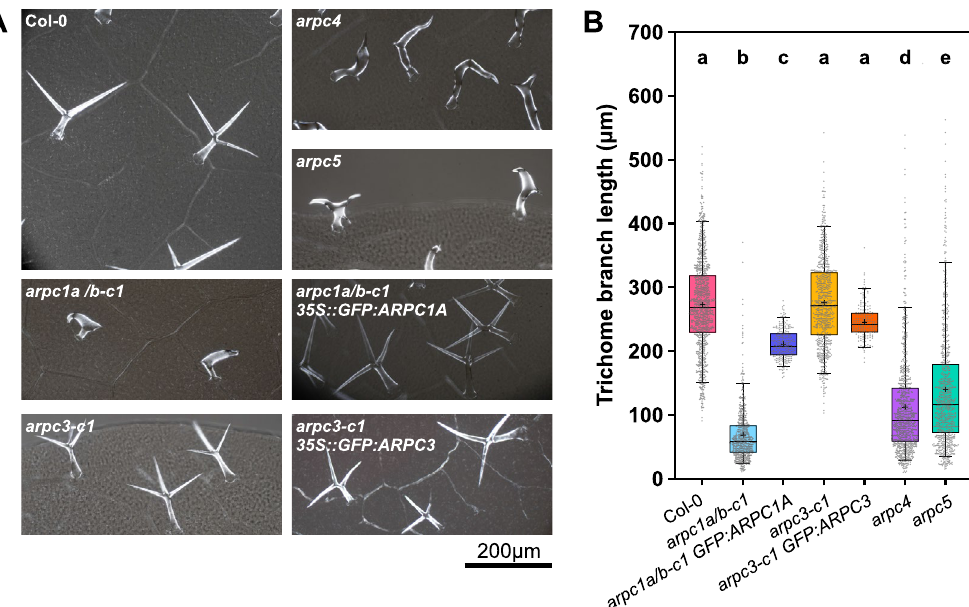
Figure 2. arpc1a/b-c1 but not arpc3-c1 show a distorted phenotype. Trichome evaluation of first true leaves from 14DAG plants reveals the “distorted”-like phenotype in arpc1a/b-c1 , but not in arpc3-c1 knockout lines. ( A ) Representative polarized light microscopy images of Col-0, arpc1a/b-c1 , arpc1a/b-c1 35S::GFP:ARPC1 , arpc3-c1 , arpc3-c1 35S::GFP:ARPC3 , arpc4 , arpc5 trichomes. ( B ) Quantification of trichome branch length. Statistical analysis was performed by fitting a linear mixed model on double squared root-transformed data followed by posthoc Tukey contrasts. Different letters denote statistical significance ( p < 0.01). n = 170–970 trichome